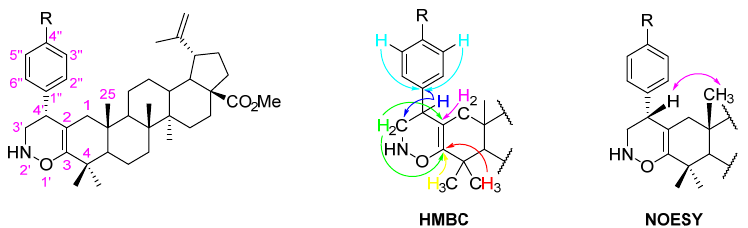
Figure 3. Adopted numbering system, structures of four possible diastereomers I to IV and main NOE effects for Michael adducts 4a-c . Ar = aryl group. )